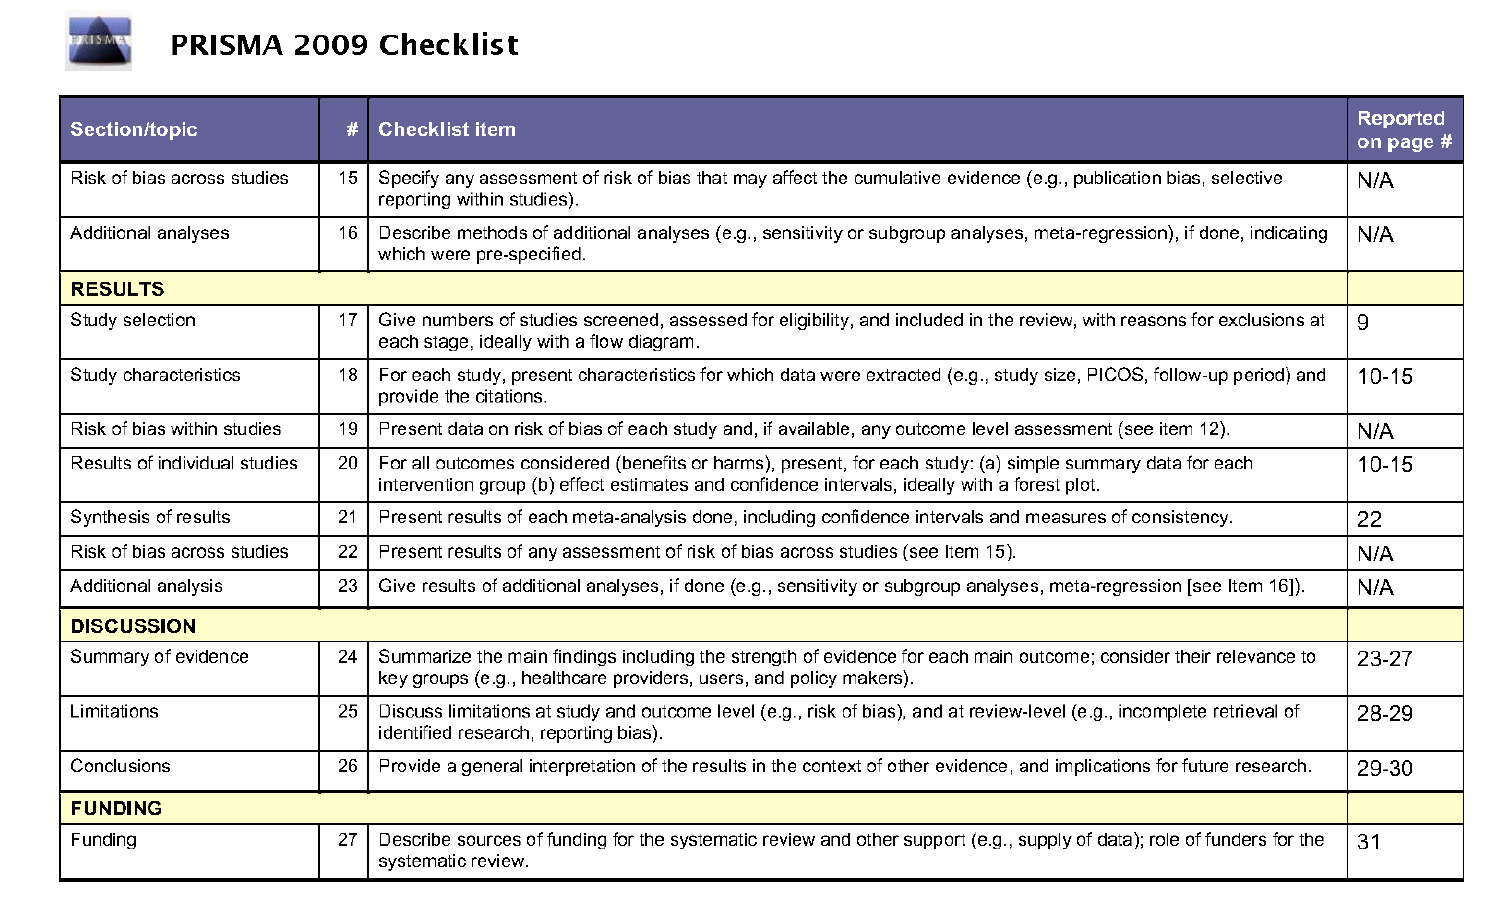
Figure A1. PRISMA Checklist. Source: Moher, D.; Liberati, A.; Tetzlaff, J.; Altman, D.G.; Altman, D.; Antes, G.; Atkins, D.; Barbour, V.; Barrowman, N.; Berlin, J.A.; et al. Preferred reporting items for systematic reviews and meta-analyses: The PRISMA statement [26].